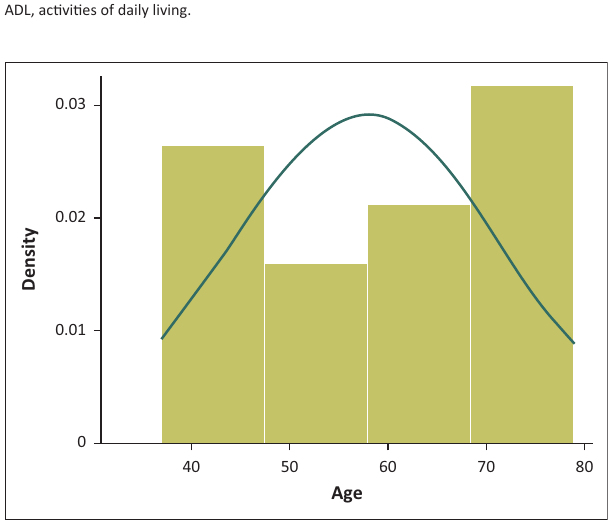
FIG URE 1: Normality histogram testing skewness of participants’ age.